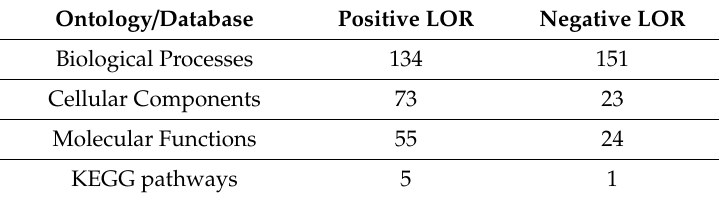
Table 3. Number of significant GO terms and KEGG pathways resulting from each meta-analysis. Positive and negative LOR represent overrepresentation in female and male AUD patients, respectively.